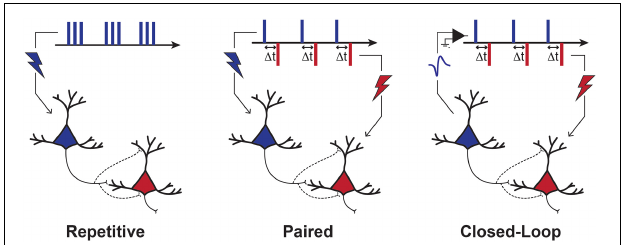
FIGURE 1 | Stimulation Paradigms to Induce Plasticity. Depiction of three main stimulation strategies used to induce plasticity. With repetitive stimulation, pre-synaptic neurons are activated directly and post-synaptic neurons are activated transsynaptically. With paired stimulation, the synchronization of pre- and post-synaptic populations is controlled directly by the stimulation of two points of the nervous system. Repetitive and paired stimulation can be applied in an open-loop manner, with no regard to current brain or behavioral state. In closed-loop approaches, however, the stimulation of a neuronal (post-synaptic) population can be precisely timed with neuronal activity (e.g., action potentials or EEG). These three different strategies all aim to induce coincidental activity in pre- and post-synaptic neurons with such a timing that would result in either LTP- or LTD-like effects, according to the rules of Hebbian